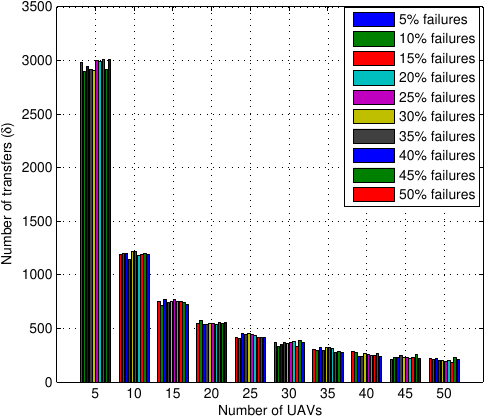
Figure 8. Number of transfers vs. number of UAVs at varying percentages of